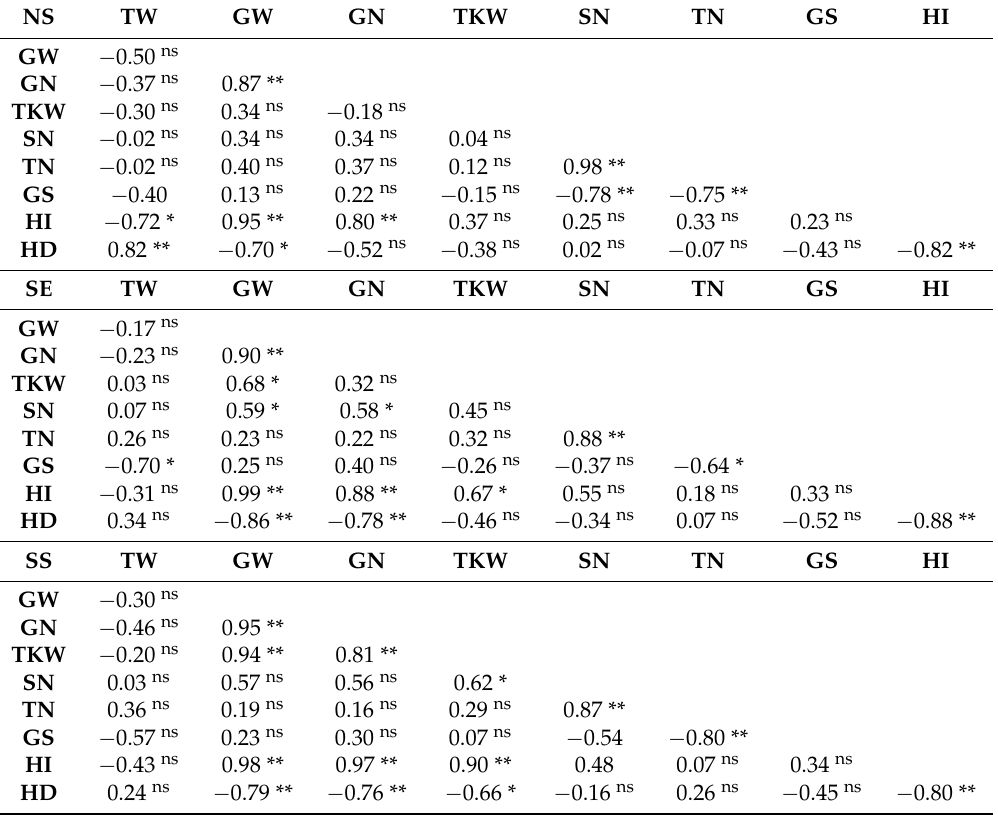
Table 5. Spearman’s coefficients of agronomic traits for the 11 barley genotypes evaluated under in three testing environments (NS, SE, and